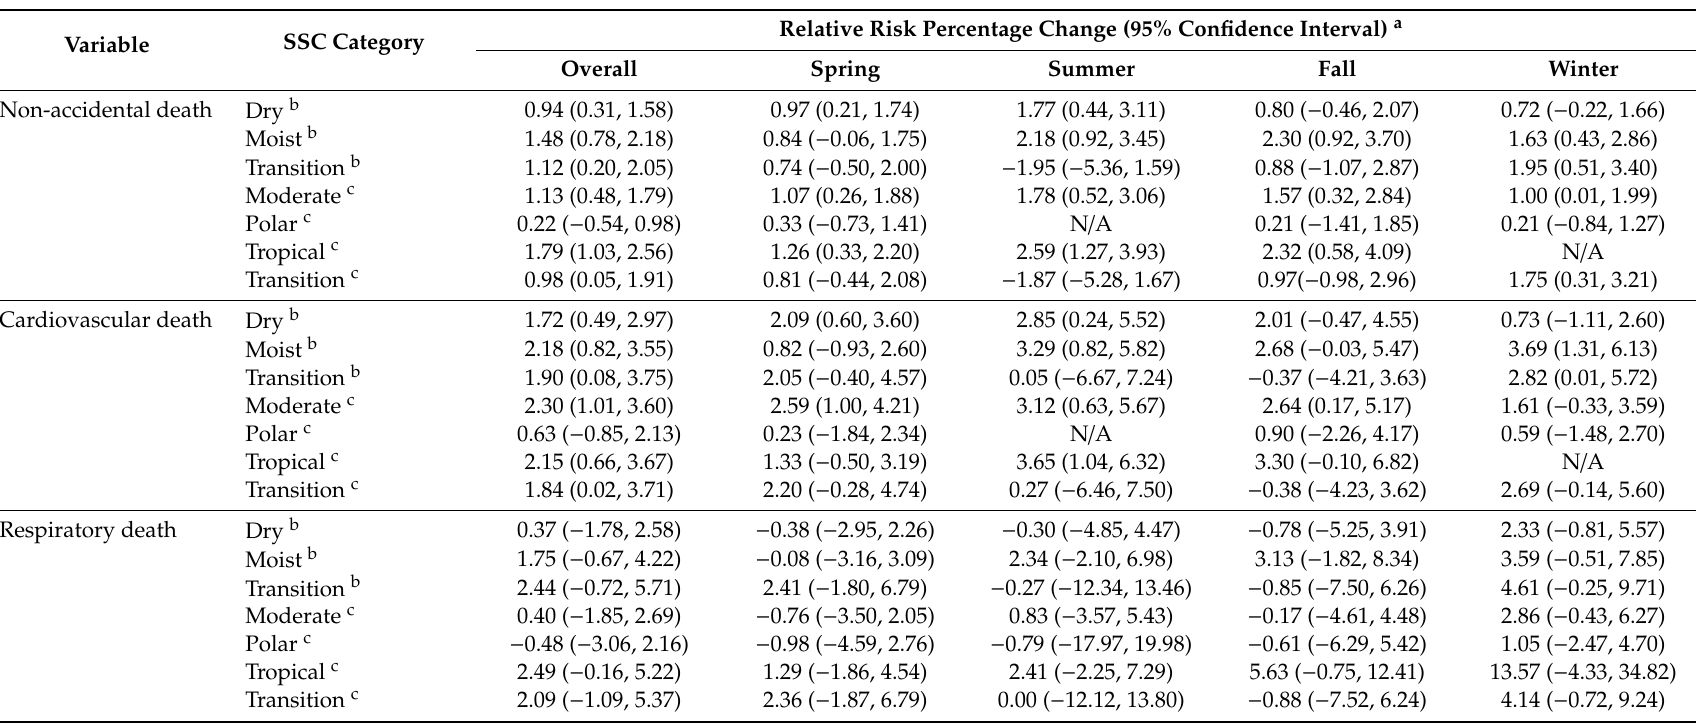
Table 4. Relative risk percentage change between daily mortality and PM 10 concentration according to SSC types in Seoul, South Korea.